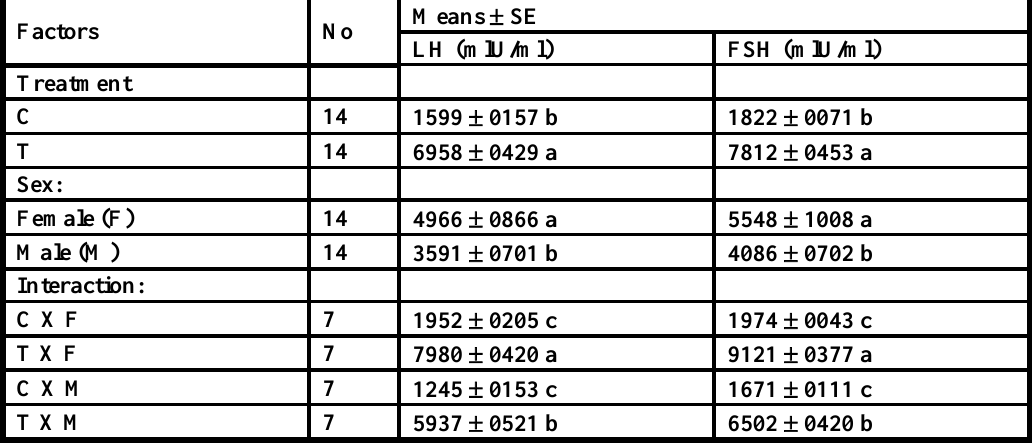
Table 3 Effects of Ns oil on LH and FSH in male and female rats